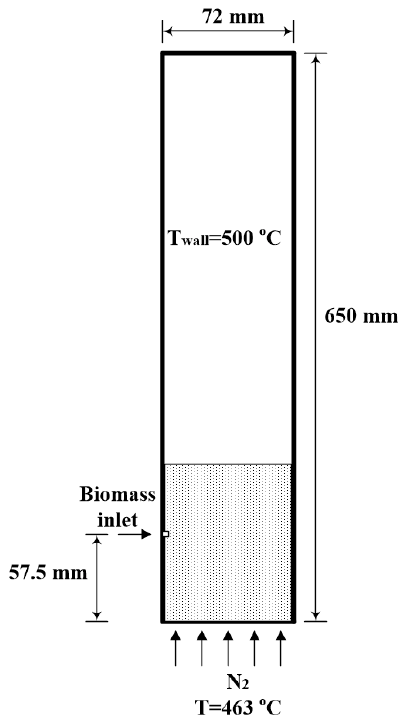
Figure 2. Geometry of the fluidized-bed reactor and pyrolysis conditions. Table 3. Simulation setups of the fluidized-bed reactor.